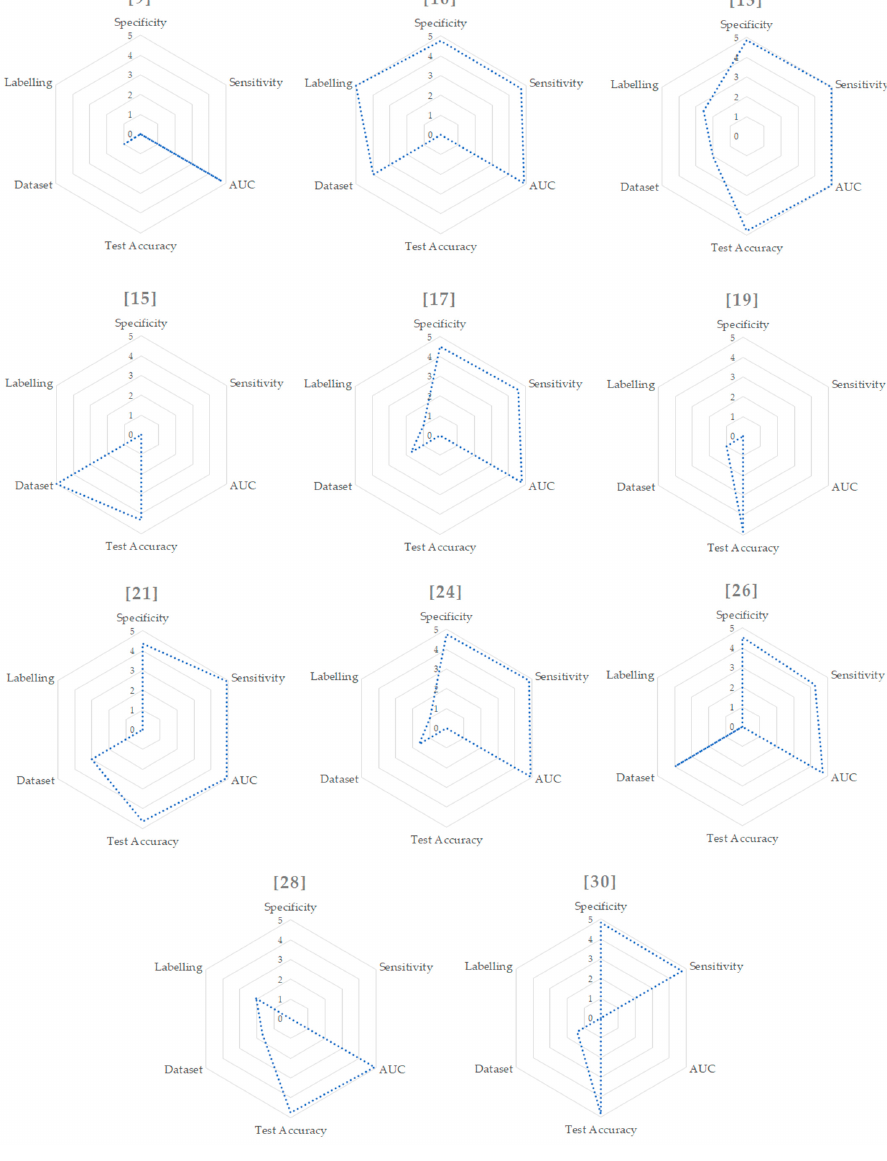
Figure 2. Radar graphs for each paper.